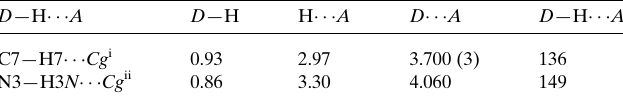
Table 1 Hydrogen-bond geometry (A˚ , (cid:3) ). Cg is the centroid of the C11–C16 ring.